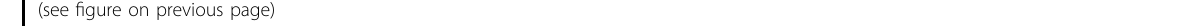
Fig. 3 Whole-cell currents produced by KCNQ4 mutants. a Representative whole-cell current traces recorded in CHO cells transfected with wild- type (WT) and mutant KCNQ4 with step pulses from − 80 mV to 40 mV in 20 mV steps. b Mean current-voltage (I – V) relation curves obtained from steady-state currents elicited at each step pulse voltage. c Summary bar graph of steady-state currents elicited at 40 mV normalized to membrane area (capacitance), obtained from whole-cell current recordings as presented in A. Averaged whole-cell current densities were 151.9 ± 11.6 pA/pF ( n = 30), 61.5 ± 8.8 pA/pF ( n = 19), 68.6 ± 7.8 pA/pF ( n = 17), 81.8 ± 16.4 pA/pF ( n = 12), 61.6 ± 4.3 pA/pF ( n = 15), 82.3 ± 9.5 pA/pF ( n = 19), 38.5 ± 5 pA/ pF ( n = 16), 30.2 ± 3.8 pA/pF ( n = 12), 30.4 ± 5.9 pA/pF ( n = 8), 142.5 ± 20.5 pA/pF ( n = 4), and 32.4 ± 4.2 pA/pF ( n = 9) for WT, p.T278A, p.S273A, p. < 0.001 compared to WT. Statistical analysis was performed using one-way ANOVA with Bonferroni ’ s multiple comparison. d Dominant-negative effects of mutants on KCNQ4-mediated currents were analyzed with a 1:1 ratio of WT and mutants KCNQ4 and step pulses from − 80 mV to 40 mV in 20 mV steps. The mean I – V relation curve obtained from the steady-state current values elicited at each step pulse voltage is shown. e Summary bar graph of the steady-state currents elicited at 40 mV normalized to capacitance. The averaged whole-cell current densities were 143.6± 24.5 pA/pF ( n = 7), 56.6 ± 4.5 pA/pF ( n = 11), 69.4 ± 1.1 pA/pF ( n = 9), 72 ± 16.4 pA/pF ( n = 12), 66.1 ± 6.7 pA/pF ( n = 10), 72.9 ± 15.9 pA/pF ( n = 10), 46.7 ± 3.4 pA/ pF ( n = 9), 40.6 ± 6.04 pA/pF ( n = 9), 58.8 ± 4.2 pA/pF ( n = 10), and 129.2 ± 32.5 pA/pF ( n = 4) for WT, p.T278A, p.S273A, p.R433W p.L281M, p.L295P,